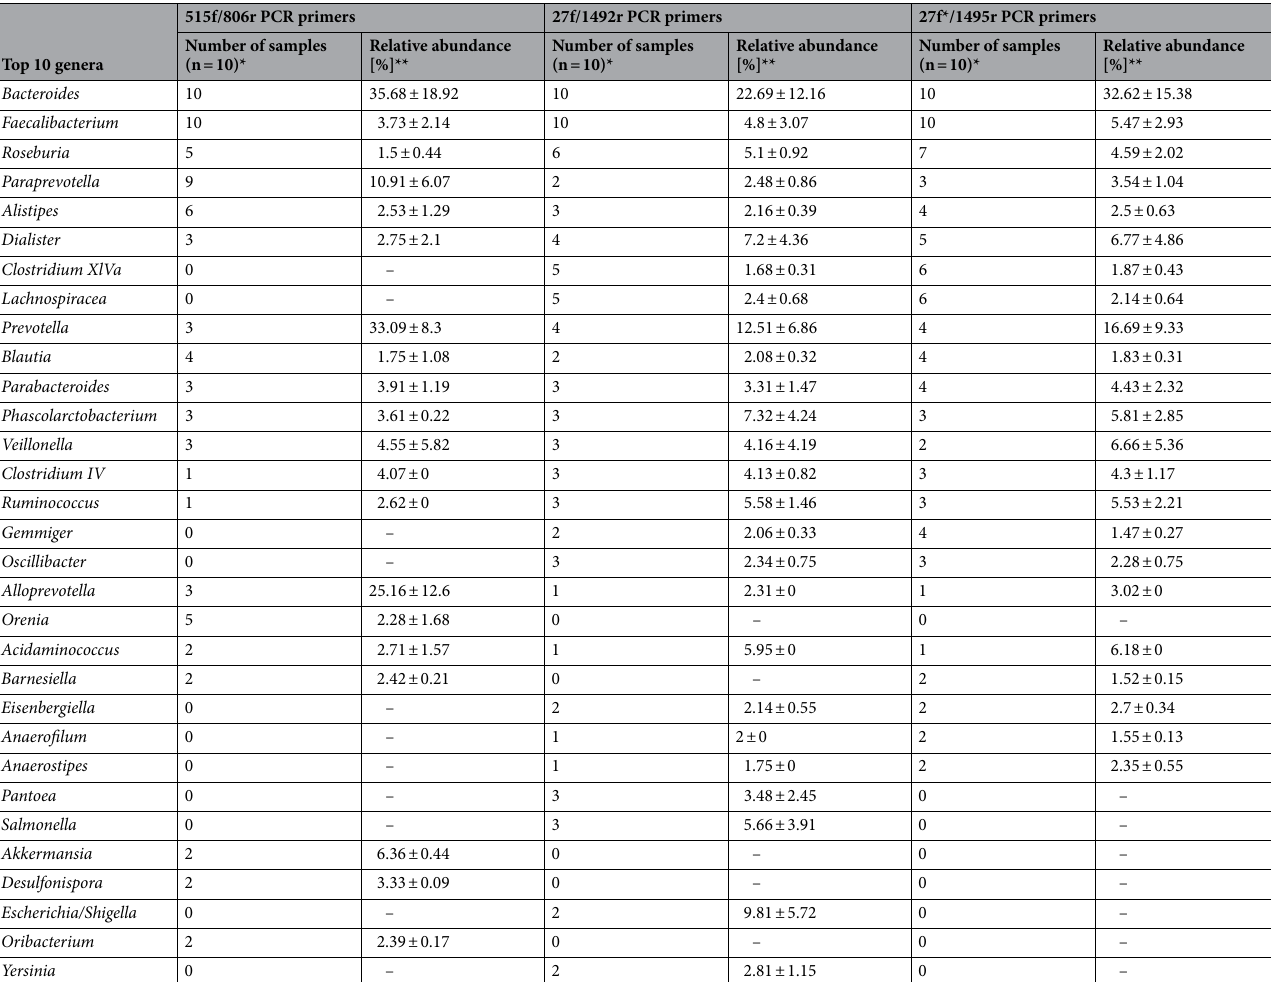
Table 4. The list of the most abundant bacterial genera in samples analysed using different type of 16S rRNA primer sets. *The number of samples in which bacteria belonged to the 10 most abundant. **Relative abundance of bacteria in total microbiota of samples in which bacteria belonged to the 10 most abundant (Data are presented as average ± standard